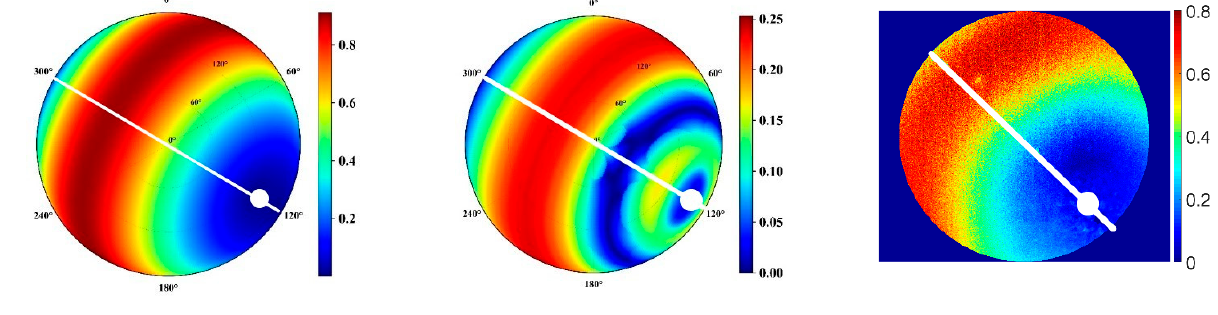
Figure 2. Local sky polarization field simulation and observation. It shows the ground-based observation results of skylight polarization. DOLP represents the ratio of polarized light to total light intensity, where its units are dimensionless with a maximum value of 1.0 .